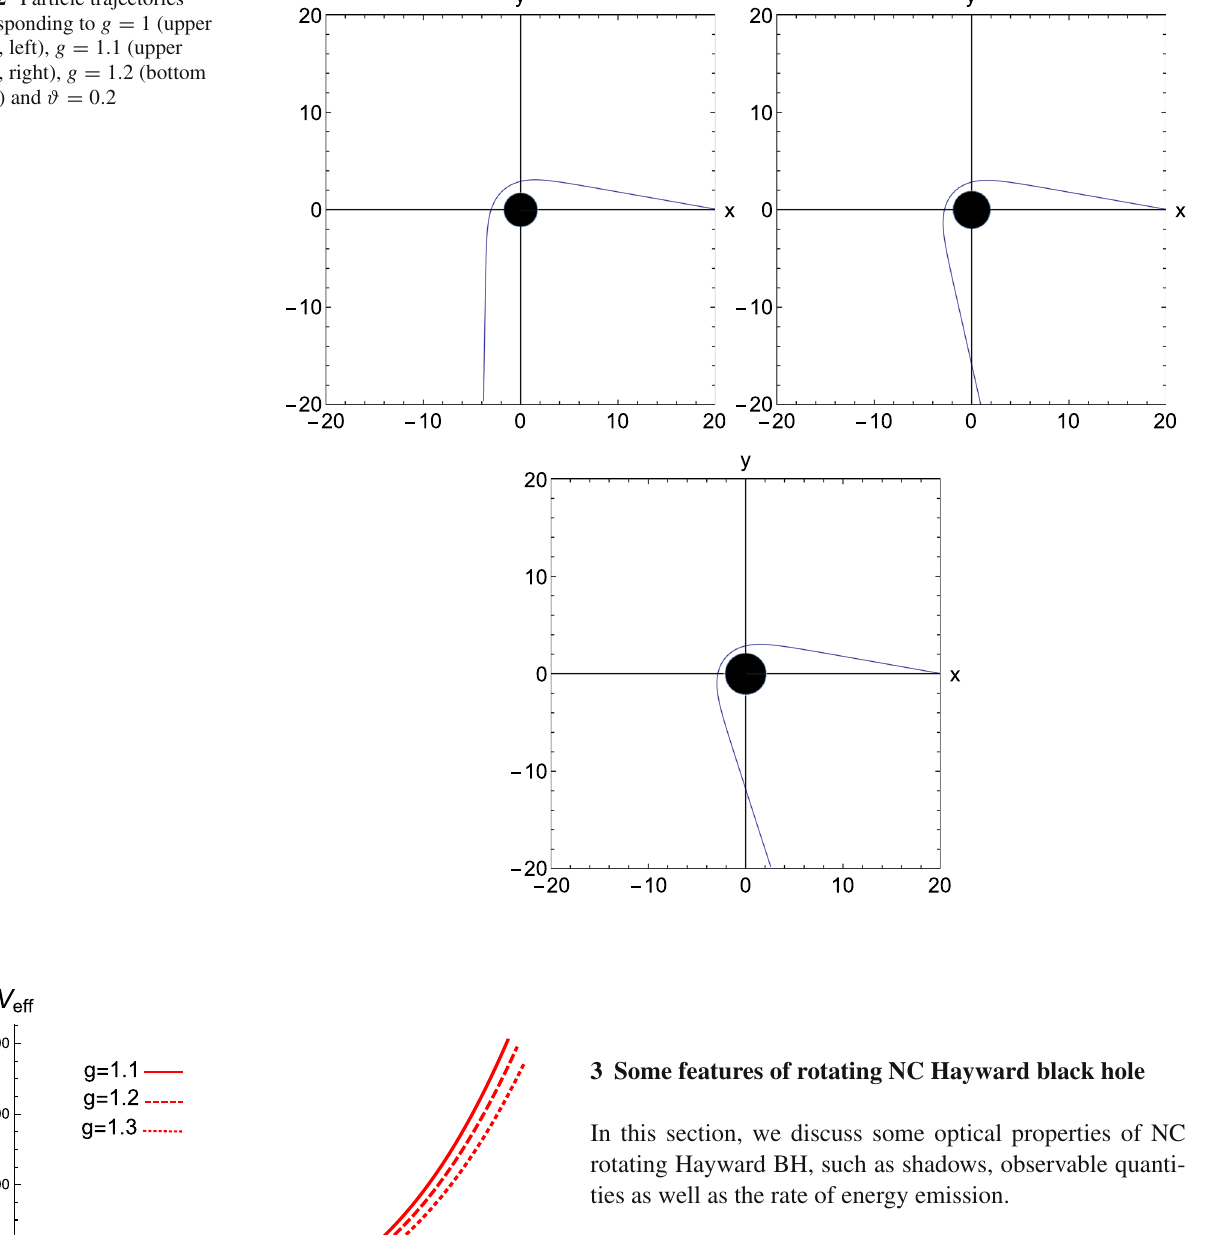
Fig. 2 Particle trajectories corresponding to g = 1 (upper panel, left), g = 1 . 1 (upper panel, right), g = 1 . 2 (bottom panel) and ϑ = 0 . 2